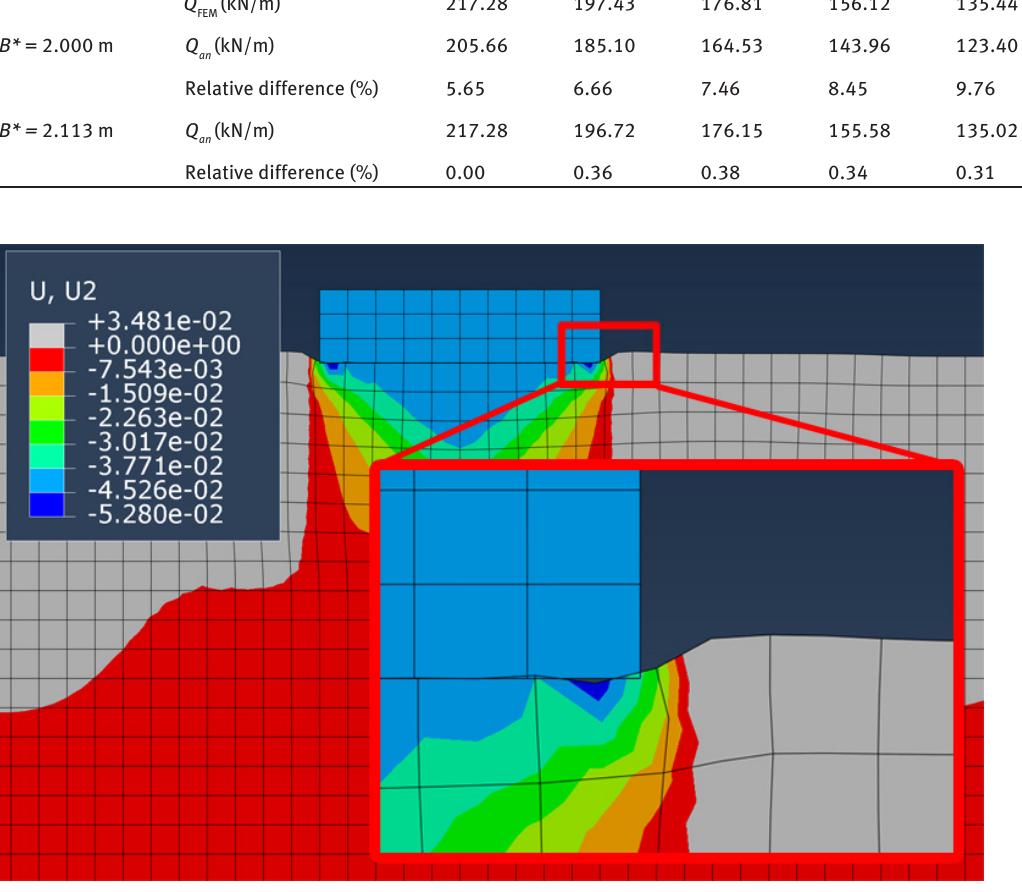
Table 2: Comparison of semi-analytical and numerical values of bearing capacity. Eccentricity e (m)